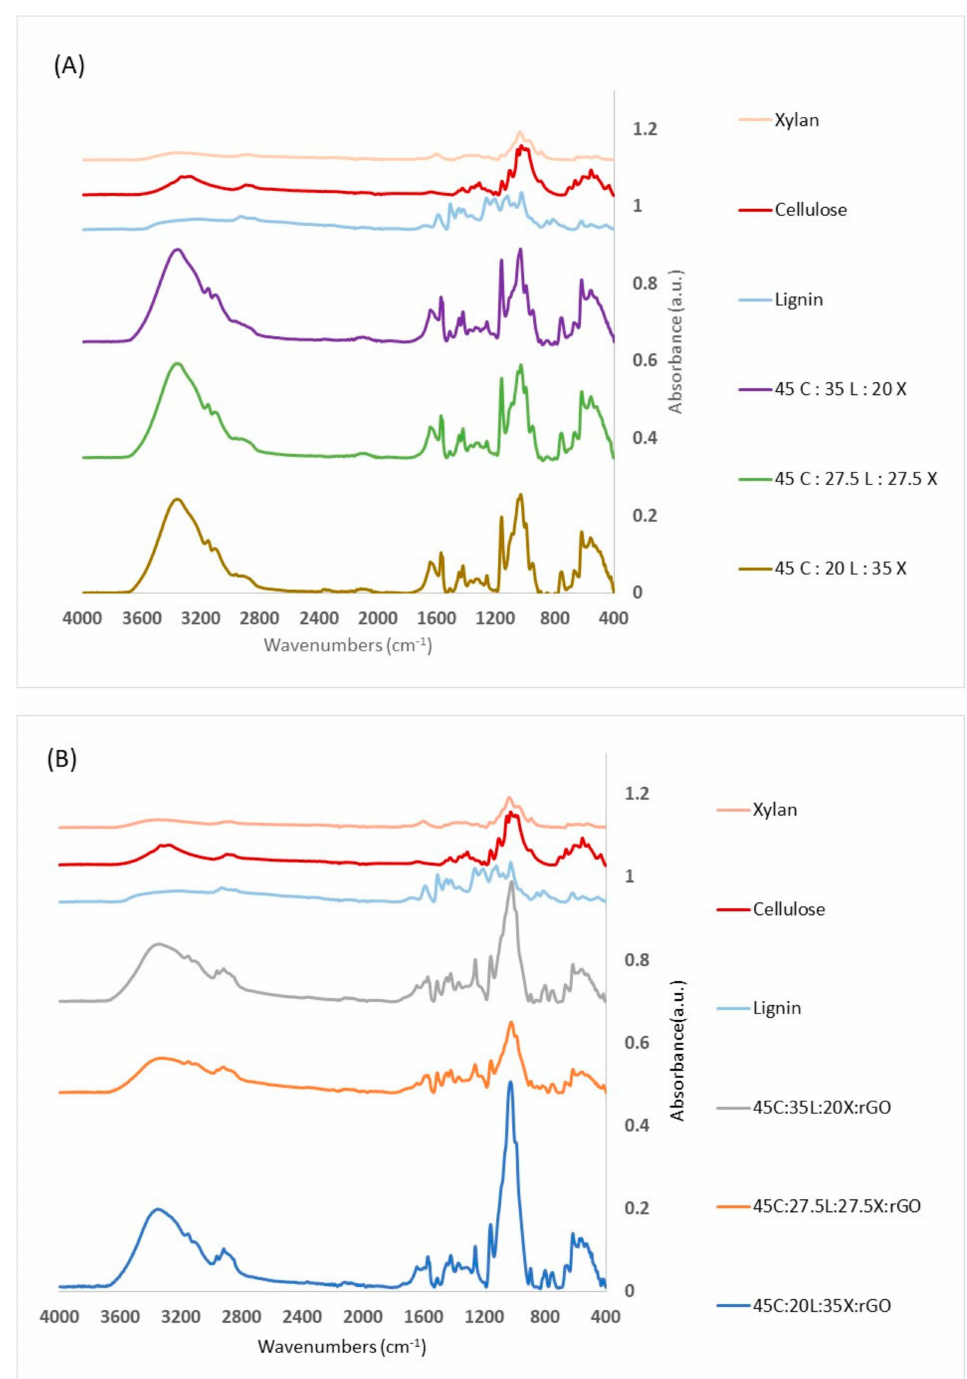
Figure 1. FTIR spectra of ( A ) material components of lignocellulosic films without rGO and ( B ) of material components of lignocellulosic films with